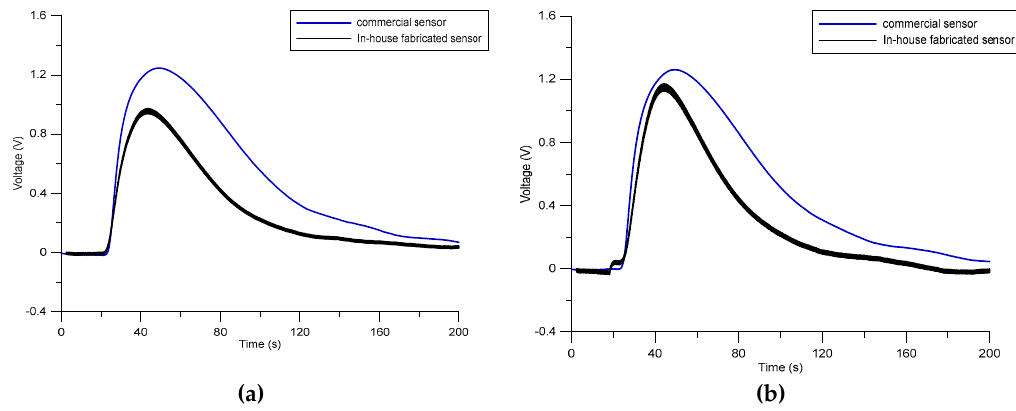
Figure 5. Comparison between the responses of the commercial and in-house built sensors towards 1000 ppm of ( a ) methanol and ( b ) methanol/THC mixture.